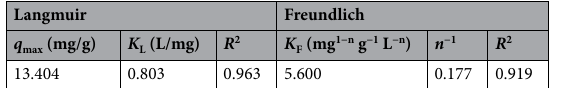
Table 6. Fitting parameters of the adsorption isotherm model.